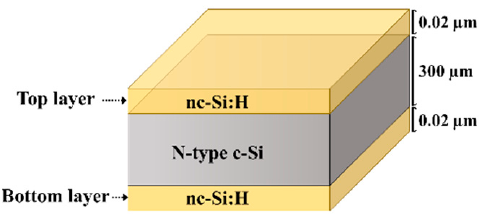
Figure 1. Schematic structure of the passivation layer of nc-Si:H deposited on an n-type crystalline silicon substrate.